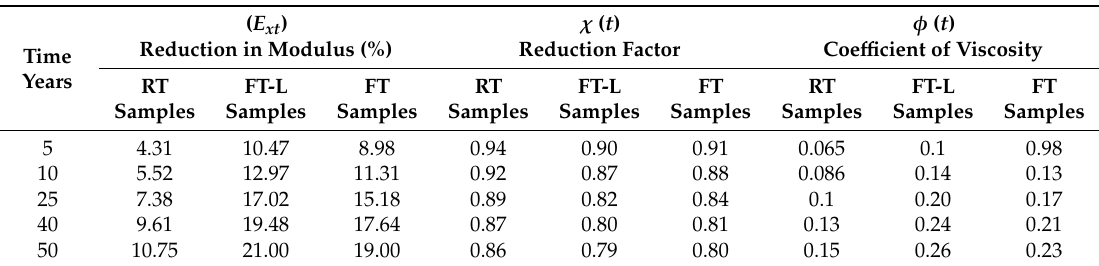
Table 5. Prediction of time dependent flexural modulus E xt , time-dependent reduction factors χ ( t ) , and coe ffi cient of viscosity φ ( t )